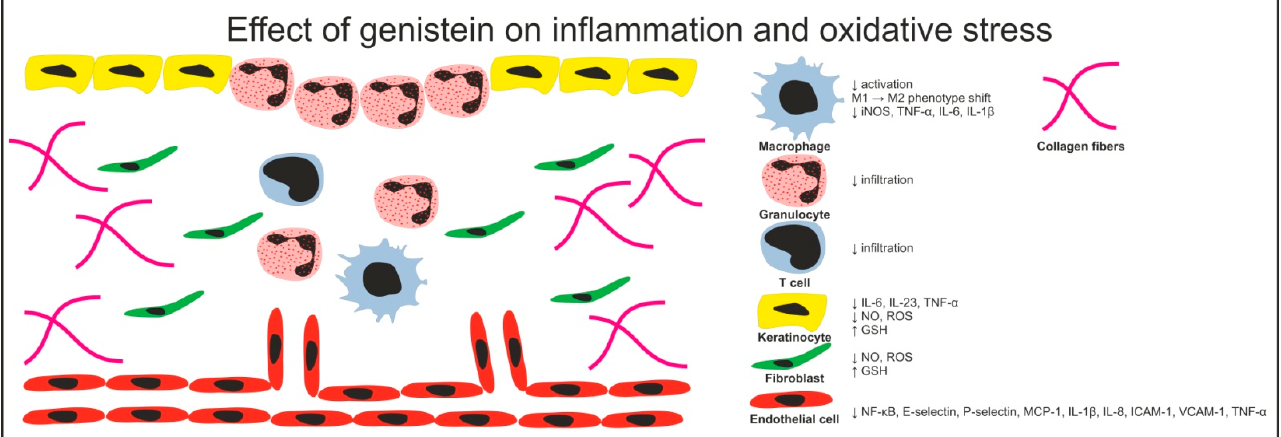
Figure 1. Cell-specific effects of genistein on wound healing during the inflammatory phase. In particular, macrophages are of high importance in wound healing as they attenuate inflammation, clear cell debris, as well as coordinate tissue repair. Genistein can inhibit activation of macrophages exposed to inflammatory stimulus by inhibiting activation of transcription factor nuclear factor kappa-light-chain-enhancer of activated B cells (NF- κ B), as well as signal transducer and activator of transcription 1 (STAT-1) [43]. In detail, transcription factor NF- κ B controls the expression of inducible chemokines, cell adhesion molecules, vasoactive proteins, and anti-apoptotic proteins important for cellular stress response. The NF- κ B signaling pathway is triggered by inflammatory activators such as UV light, cytokines, free radicals, oxidized LDL (ox-LDL,) and viral antigens [44]. One part of the innate immune response regulated by NF- κ B is NOD-like receptor protein-3 (NLRP3) inflammasome. NLRP3 inflammasome is reported to have an important role in promoting the early stage of skin wound healing [45]. Genistein supplementation had a positive effect on NLRP3 expression which was reduced by diabetes in mice [46]. Apart from in vitro data, the accelerated wound closure rate observed in the early stages of healing was accompanied by decreased levels of inflammatory markers TNF- α and NF- κ B in genistein treated mice [46,47]. Furthermore, an in vivo study showed that genistein treatment can shift macrophage phenotype from M1 to M2 in rats with experimental colitis [48]. The switch from pro-inflammatory M1 phenotype to inflammation-resolving M2 phenotype in macrophages is crucial for the transition from the inflammatory to the proliferation phase of wound healing [40]. Genistein was also able to inhibit inducible nitric oxide synthase (iNOS) activity and production of cytokines, promoting inflammation such as tumor necrosis factor alpha (TNF- α ), interleukin (IL)-6 and IL-1 β in lipopolysaccharide (LPS)-stimulated macrophages [48].